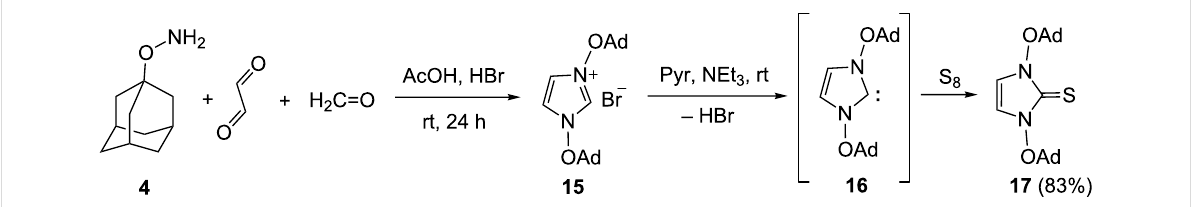
Scheme 8: Synthesis of the symmetric 1,3-di(adamantyloxy)imidazolium bromide ( 15 ) and its transformation to 1,3-dihydro-2 H -imidazol-2-thione 17 via the intermediate imidazol-2-ylidene 16